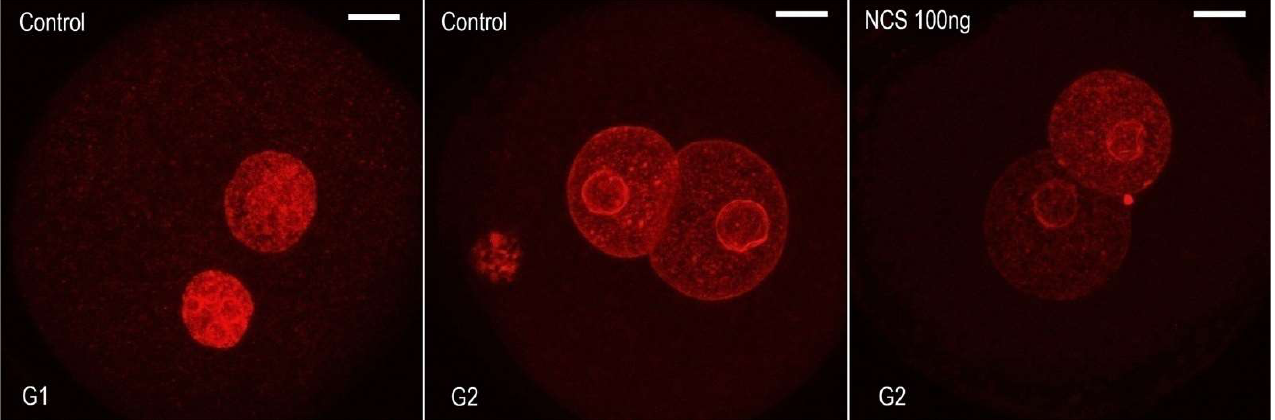
Figure 5. Propidium iodide staining of pronuclei in control (in the G1- vs.the G2-phase) and NCS-treated (in the G2-phase) one-cell embryos. The Z-projection of the confocal sections across the whole pronuclei is shown. Scale bar =10 µm.